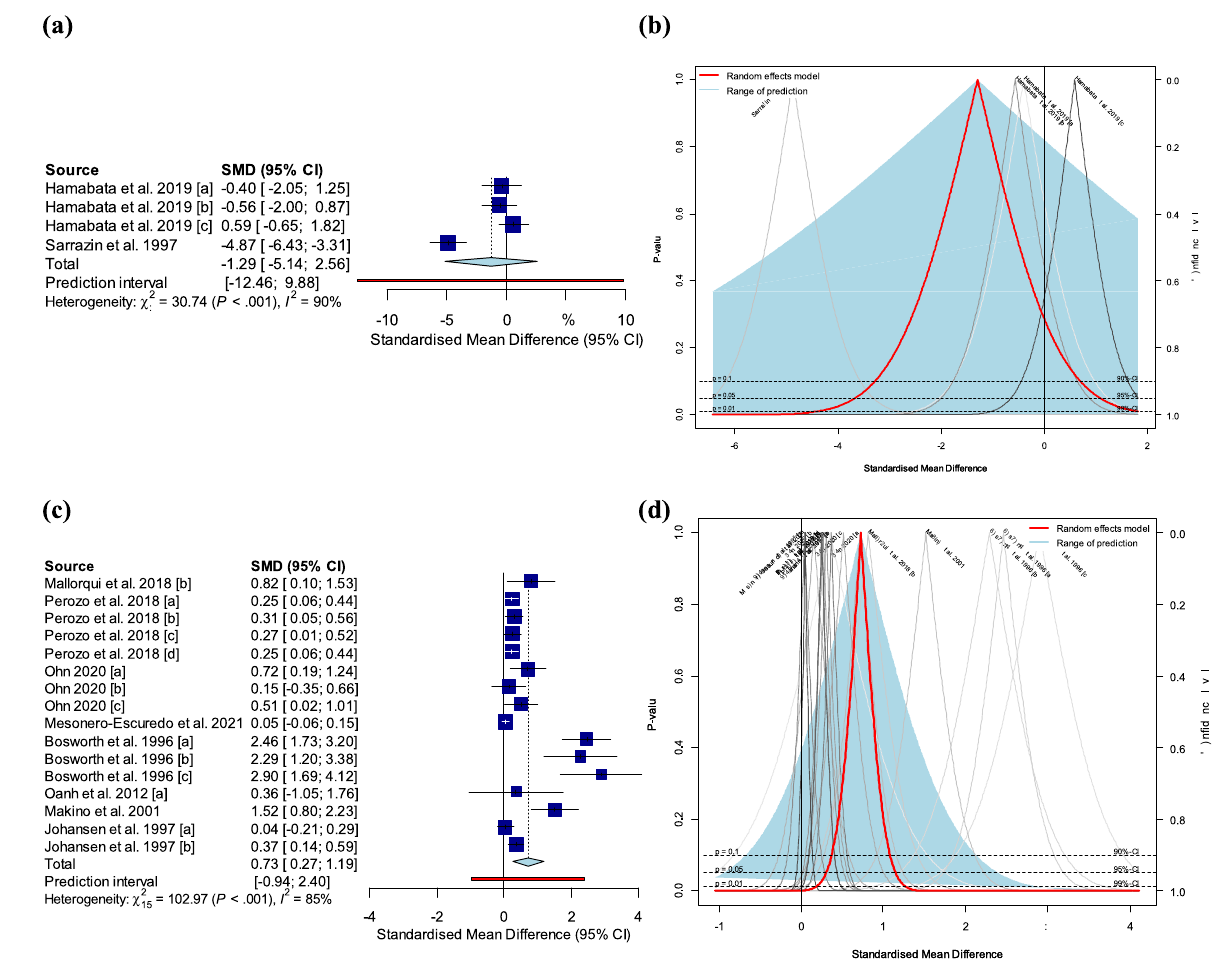
Figure 3. Results of conventional meta-analysis of edema disease-related fecal shedding and average daily gain (ADG) in pigs. ( a ) Forest plot of the Hedges’ g and 95% confidence interval for fecal shedding of Shiga toxin-producing Escherichia coli (STEC) in pigs. Size of the blue square corresponds to the weight of each study. Vertical dotted and solid lines symbolize the overall effect size and the null value, respectively. A random-effects model was used. ( b ) Drapery plot showing p -value curves for fecal shedding of STEC. A random-effects model was used. ( c ) Forest plot of the Hedges’ g and 95% confidence interval for ADG in pigs. Size of the blue square corresponds to the weight of each study. Vertical dotted and solid lines symbolize the overall effect size and the null value, respectively. A random-effects model was used. ( d ) Drapery plot showing p -value curves for ADG. A random-effects model was used. The statistical program R (version 4.1.1) was used to prepare this figure 44 .